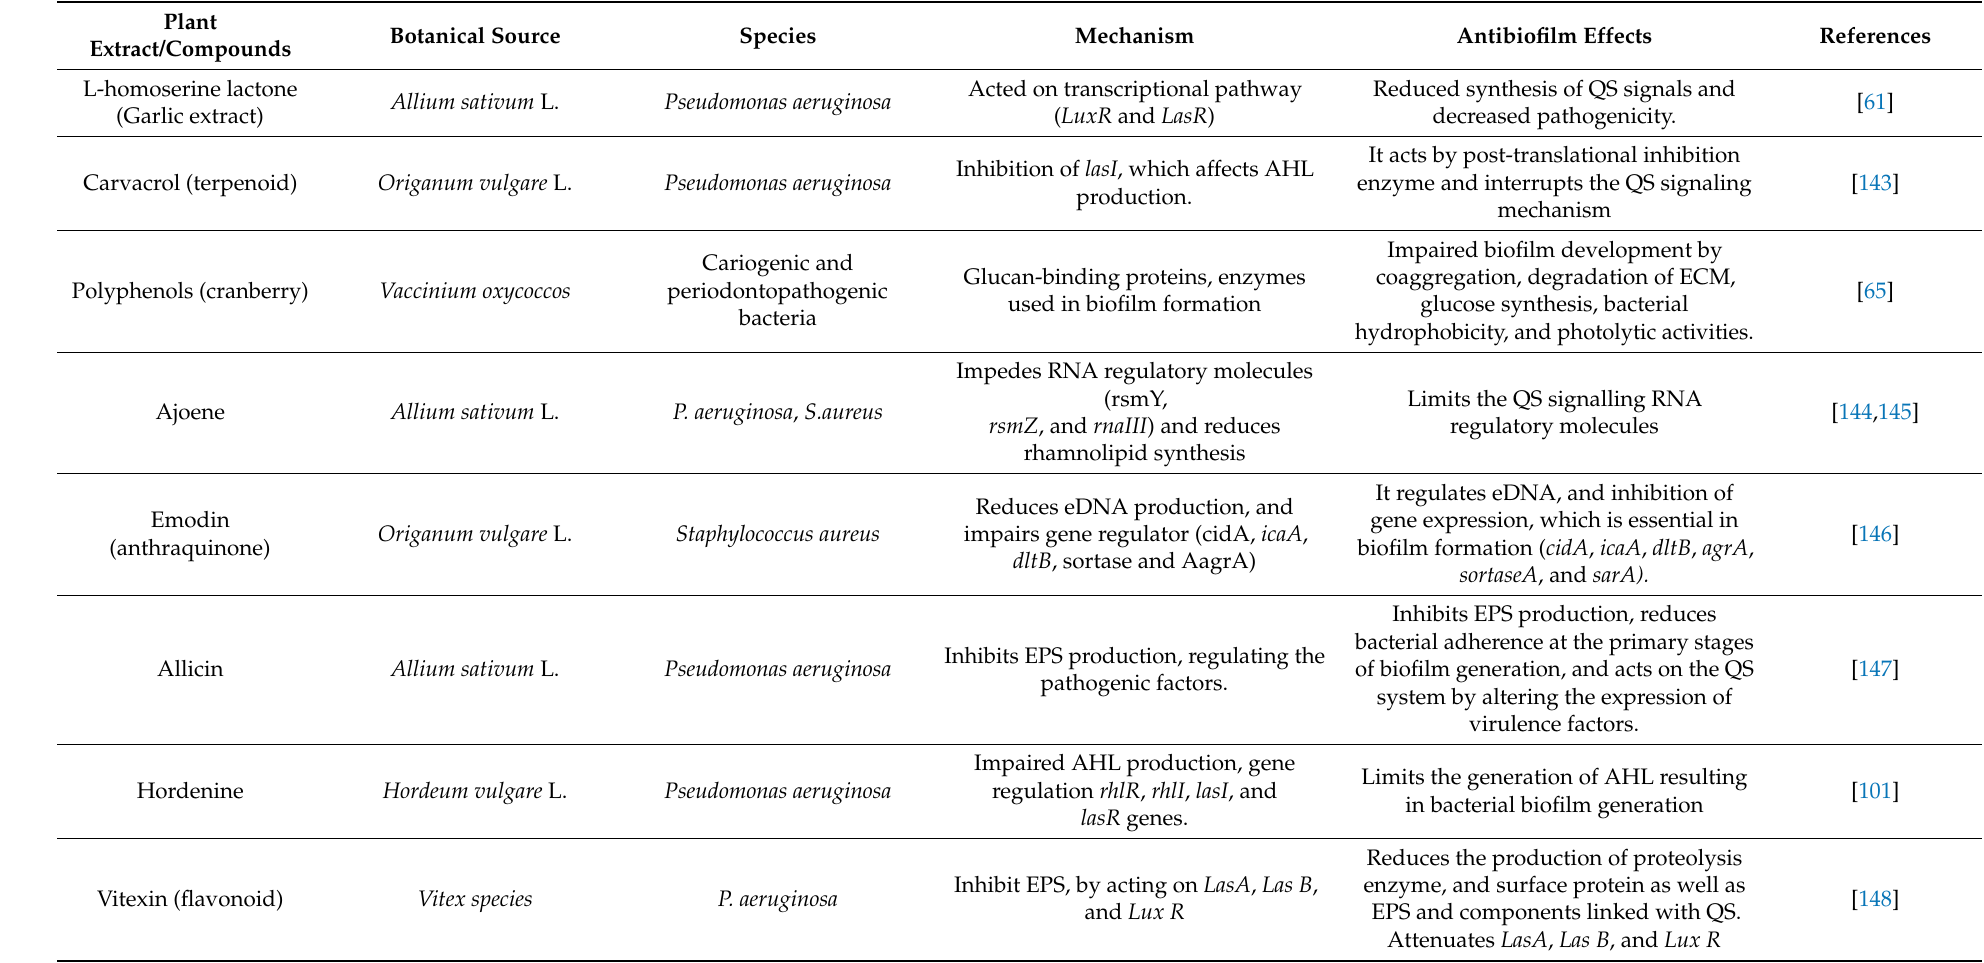
Table 1. The potential antibiofilm activity of a few natural antimicrobials